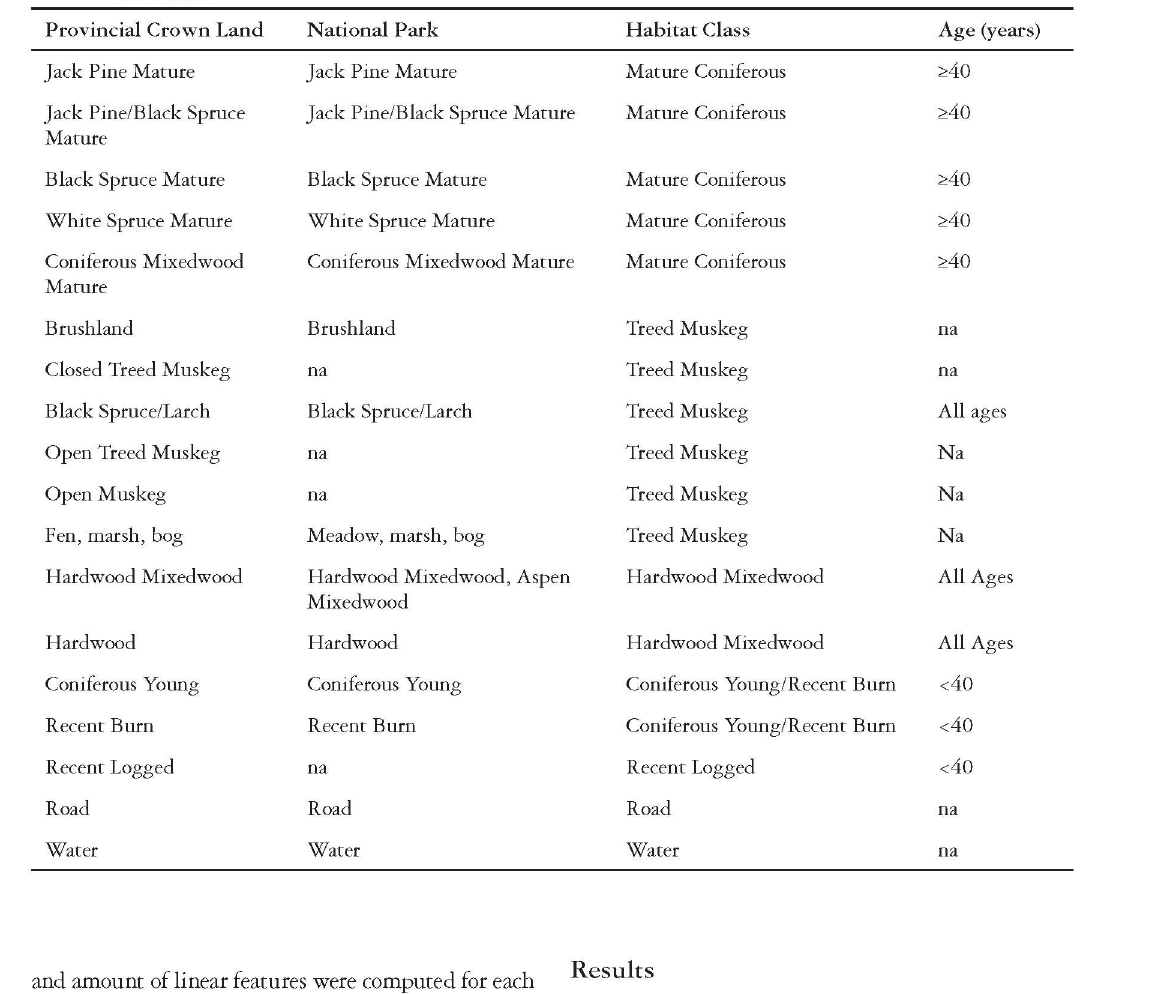
Table 1. Habitat classes used in the mapping and analyses of the provincial crown land and National Park portion of the